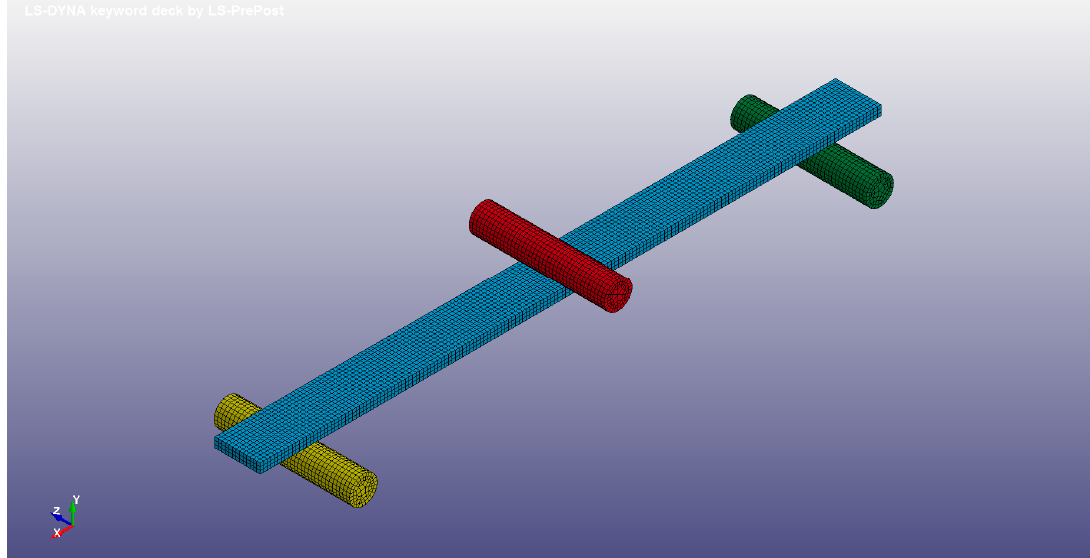
Figure 13. Three-point bending meshed model.